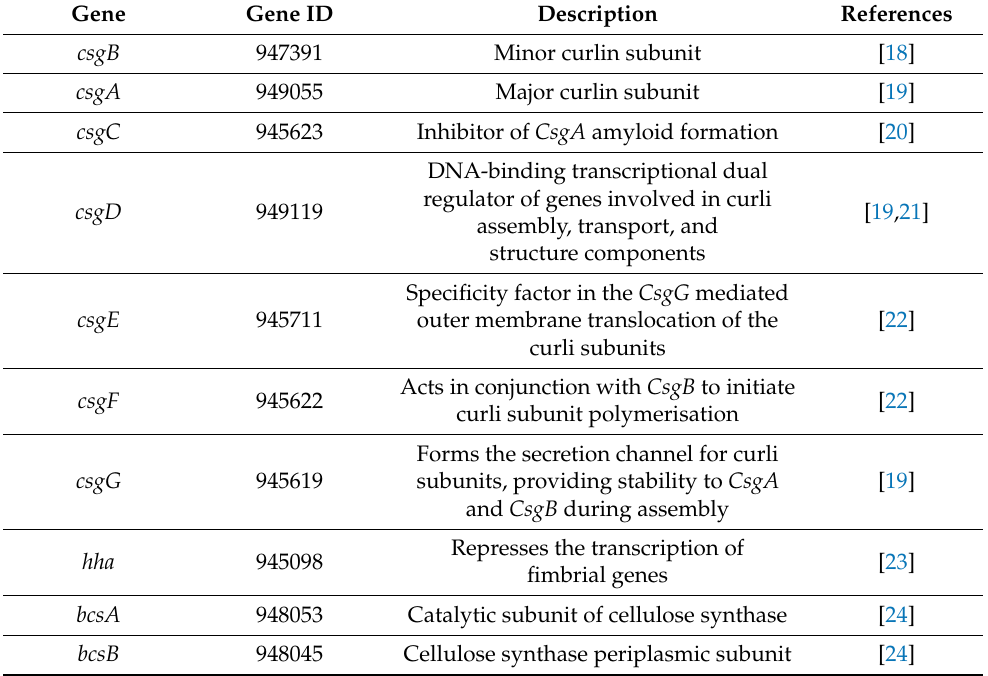
Table 1. Biofilm formation-associated